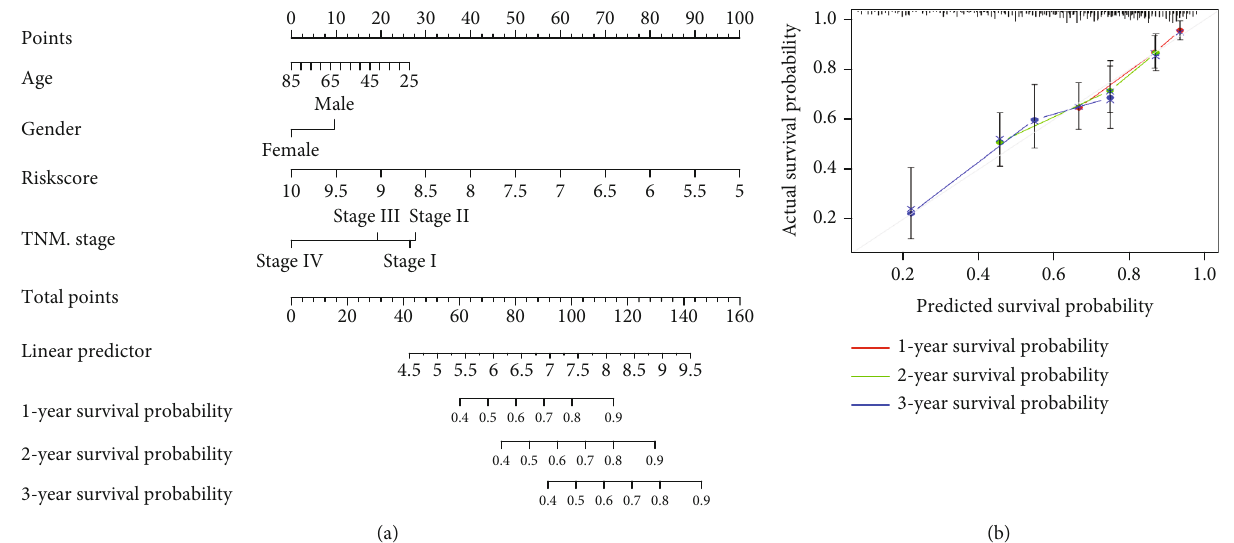
Figure 7: The predictive signi fi cance of the signatures was veri fi ed in the nomogram model. (a) Nomogram combining the four genetic signatures. (b) Calibration plots of 1-, 2-, and 3-year survival probabilities.